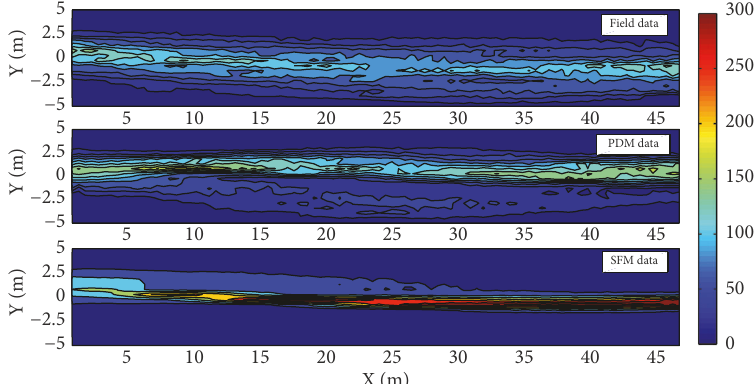
Figure 18: Distribution of nonmotorized vehicles at the Changji-Moyu